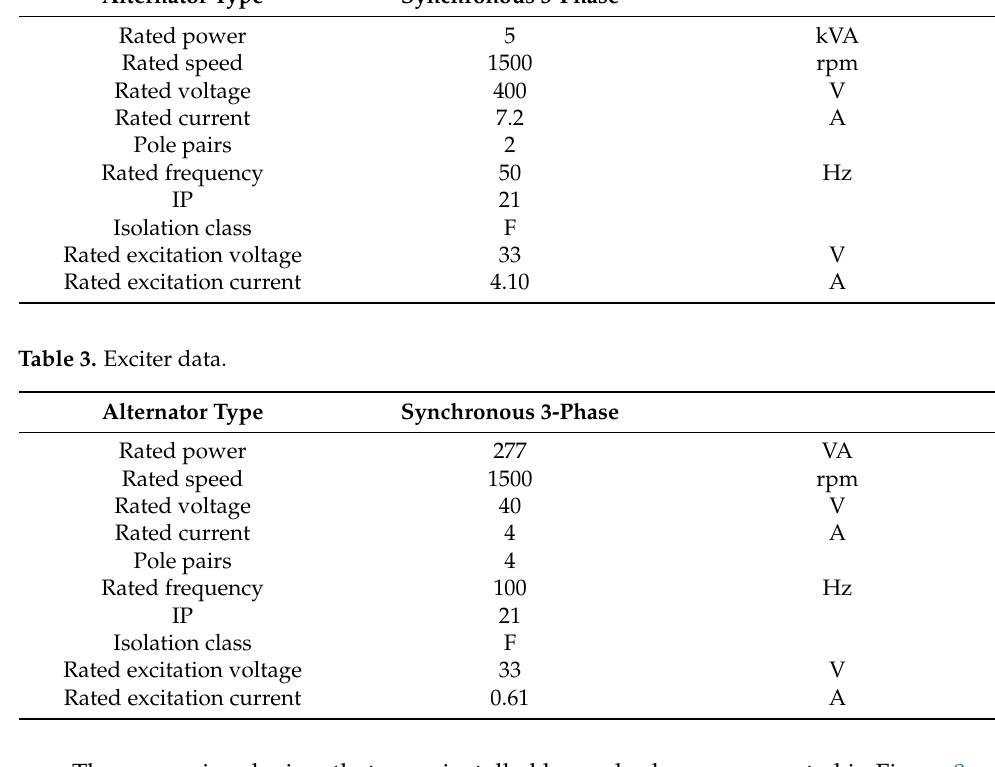
Table 3. Exciter data.